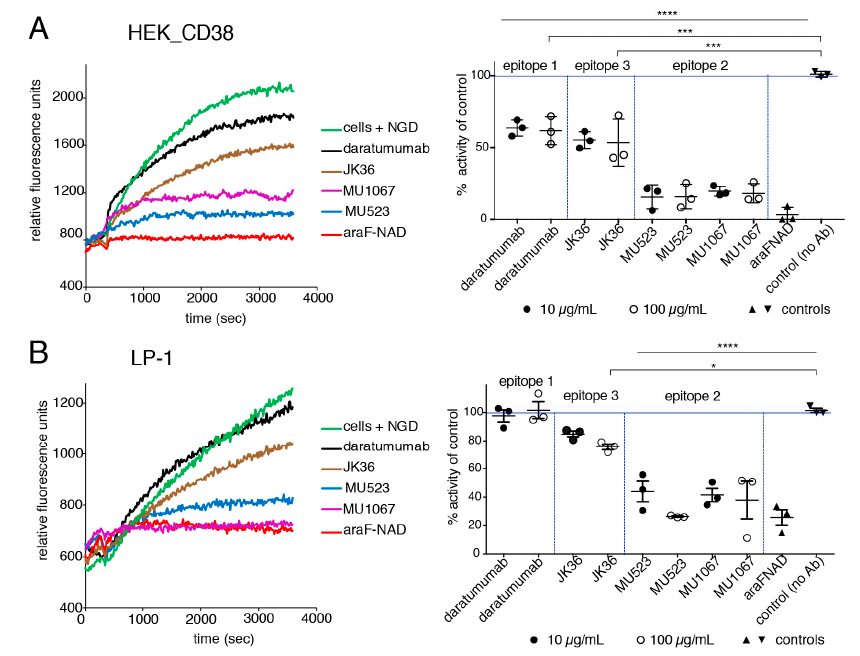
Figure 2. CD38-specific hcAbs MU523 and MU1067 potently inhibit the NGDR cyclase activity of human CD38-expressing tumor cells. The NGDR cyclase activity of CD38 expressing HEK cells ( A ) and LP-1 myeloma cells ( B ) was measured by the fluorimetric assay, as described in Figure 1D. Epitopes of daratumumab and hcAbs were assigned as described in [50]. Cells (1 × 10 5 cells/well) were incubated with the indicated hcAbs (10 μ g/mL or 100 μ g/mL), daratumumab (20 μ g/mL or 200 μ g/mL), or araF-NAD (10 μ M) for 20 min at 37 °C, before the measurement was started. After the first 20 cycles, 50 μ M NGD + was added and kinetic fluorescence reading (ex/em: 300/410 nm) was continued for 50 min. Cyclase activity was quantified by calculating the slope of curves of (A, B, left panel) during the linear phase, i.e., from t = 500 seconds to t = 1200 seconds ( n = 3). Statistical analysis was performed using one-way ANOVA, followed by a Tukey post-hoc test for multiple comparisons. * p < 0.05; *** p < 0.001, **** p < 0.0001.